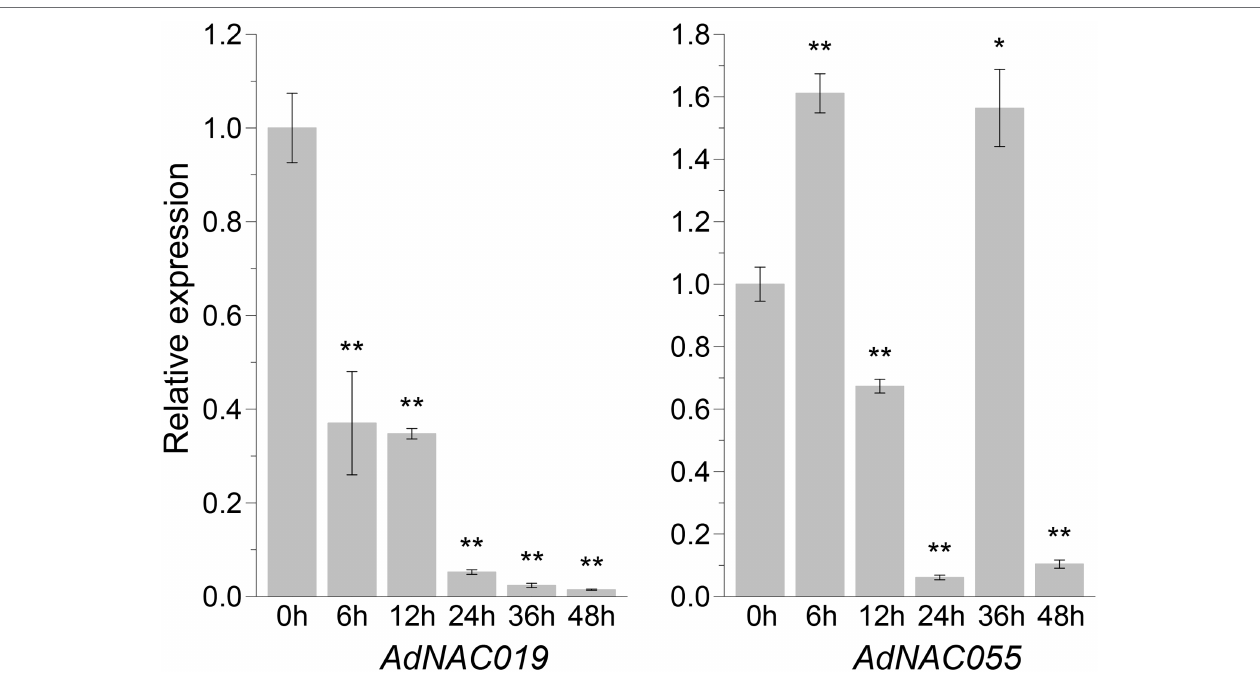
FIGURE 7 | Differential expression levels of genes that are translated proteins interaction with AdWRKYs under drought stress detected via quantitative real-time PCR. Four-leaf plants were treated with 10% (w/v) PEG6000. The leaves were collected after 0, 6, 12, 24, 36, and 48 h of treatments. The control was sampled from 0 h. Three biological replicates were used. Asterisks * and ** indicate significant differences at 0.05 and 0.01 using t tests, respectively.